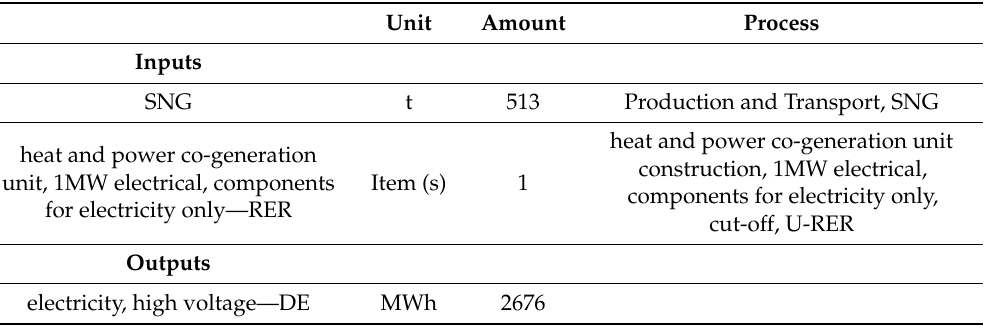
Table A15. Reconversion, SNG.